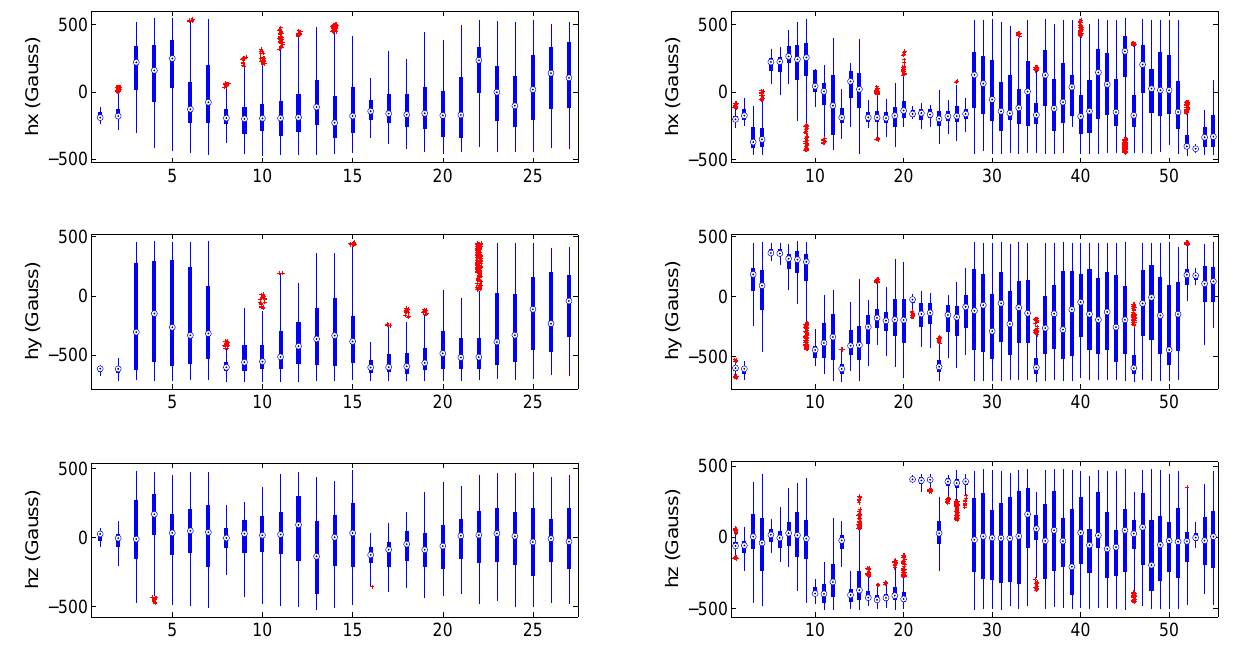
Figure 3. Boxplot of gathered magnetic field components ( h column ), dataset 2 ( right column ). X axis displays the distribution